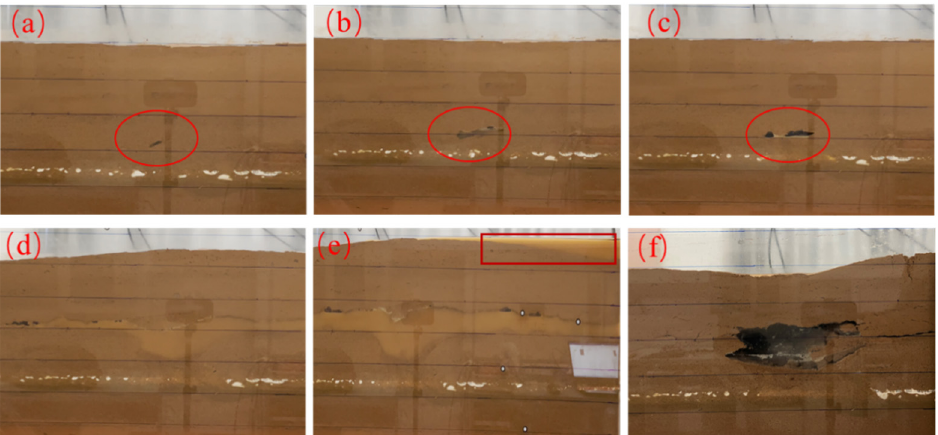
Figure 6. Evolution of an underground cavity formed by pipe seepage erosion from a circular crack 20 mm in diameter: ( a ) t = 60 s, first appearance of cavity; ( b ) t = 140 s, cavity becomes larger and stable; ( c ) t = 160 s, cavity shrinks after unloading; ( d ) t = 490 s, cavity expands suddenly; ( e ) t = 530 s, topping up the ground and water bursting onto the ground; ( f ) t = 560 s, ground collapse.